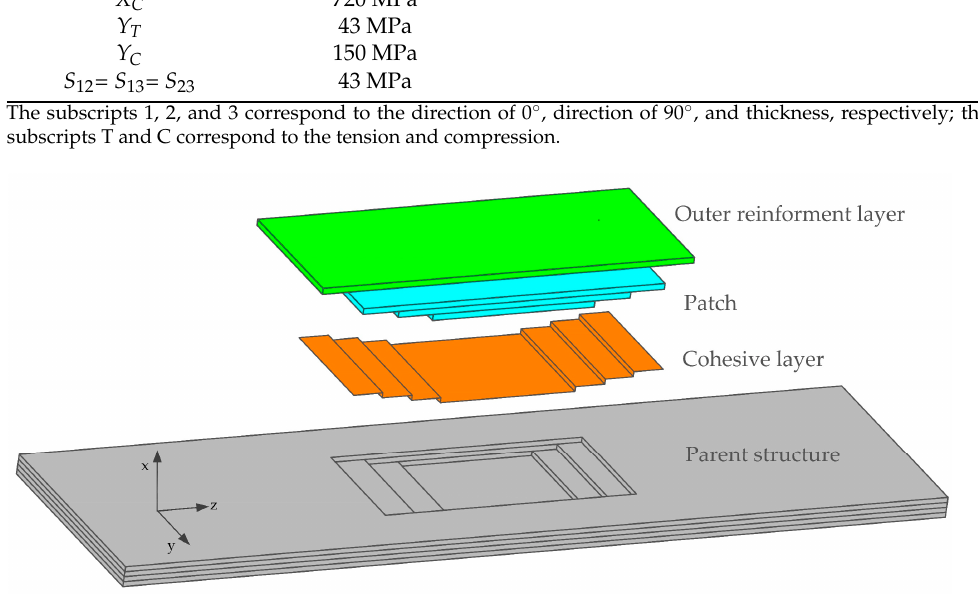
Figure 7. Boundary conditions and displacement load of structural analysis model.